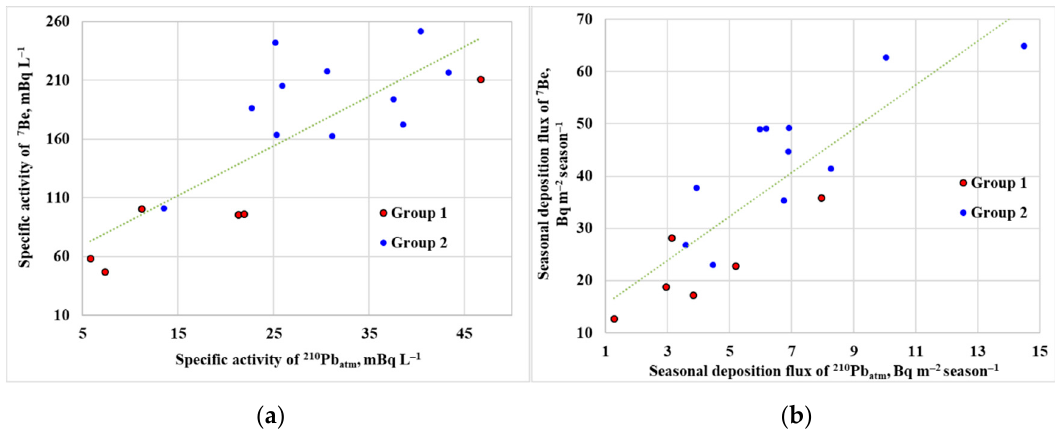
Figure 15. Correlation of ( a ) specific activities of 210 Pb atm and ( b ) its seasonal deposition fluxes with 7 Be in the finely dispersed fraction (<0.45 μ m) of suspended matter in snow water.